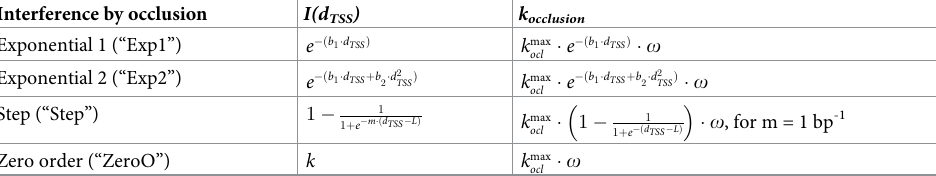
Table 1. Potential models of transcriptional interference due to promoter occlusion considered. Interference by